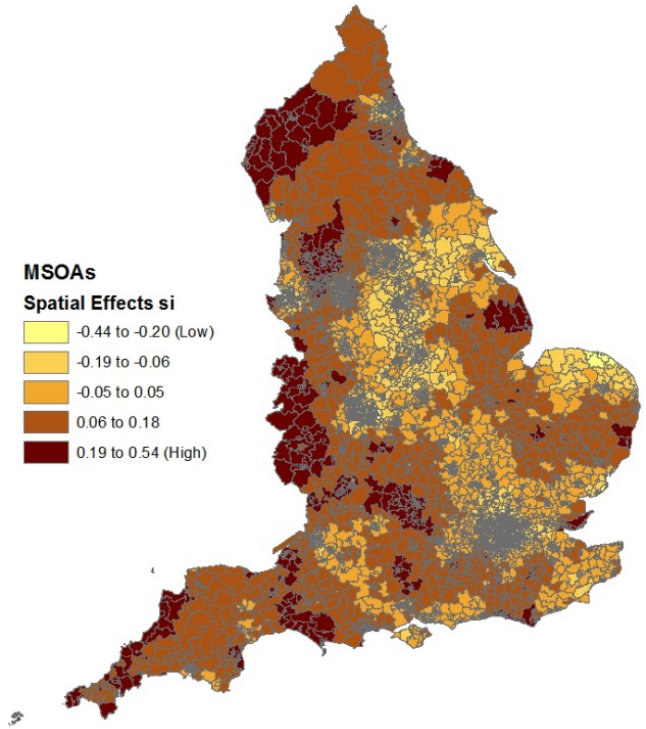
Figure 2. Spatial effects in suicide regression after controlling for construct scores.